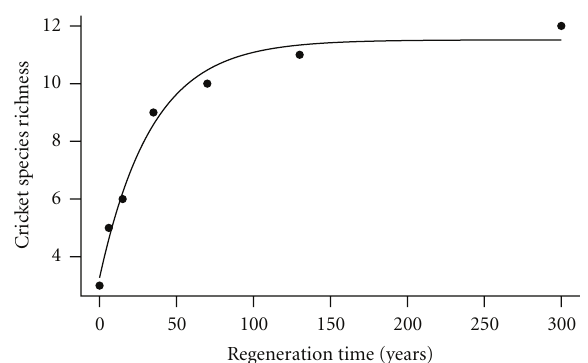
Figure 2: Response of cricket species richness to regeneration time. Species richness increased asymptotically up to 130 years of regeneration. Nonlinear regression with Gaussian errors: y = 11 . 293 − 8 . 081 ( − 0 . 003 ∗ x ) ; F 2,4 = 16 . 16; P = 0 .